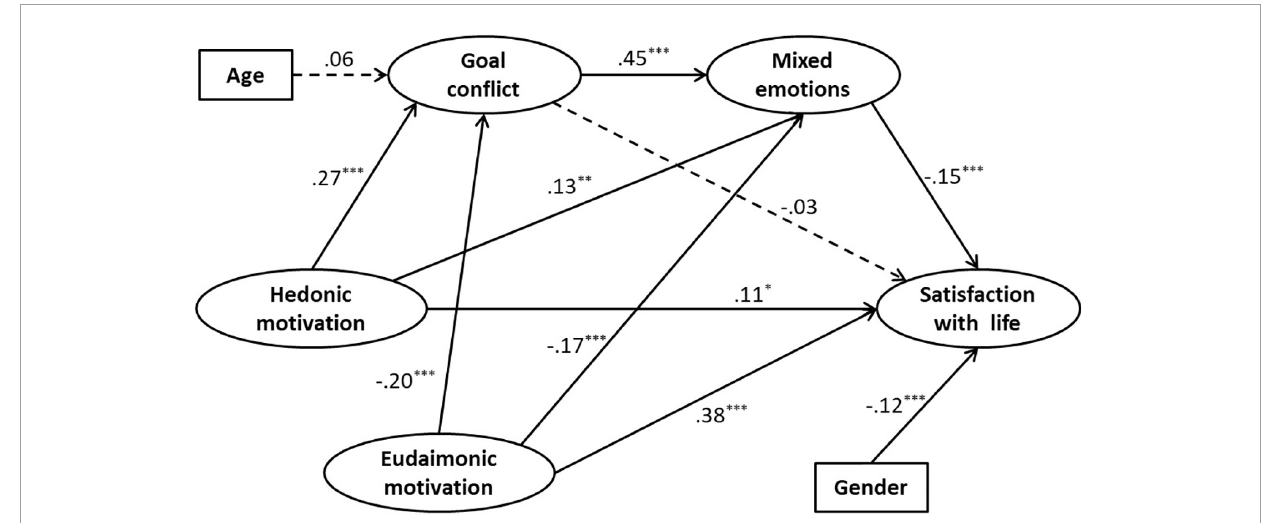
FIGURE2 The chain mediating effect model of goal conflict and mixed emotions.